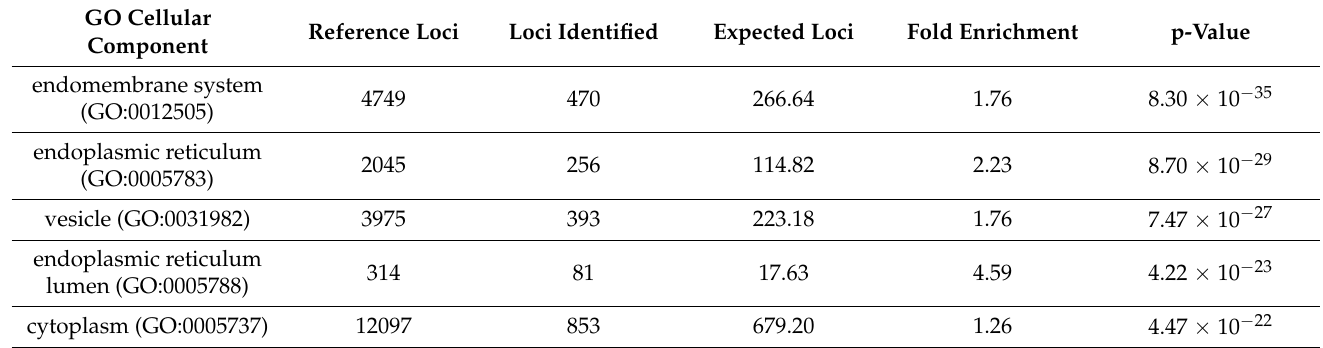
Table 2. GO cellular component analyses showing the top five systems by lowest p-value using